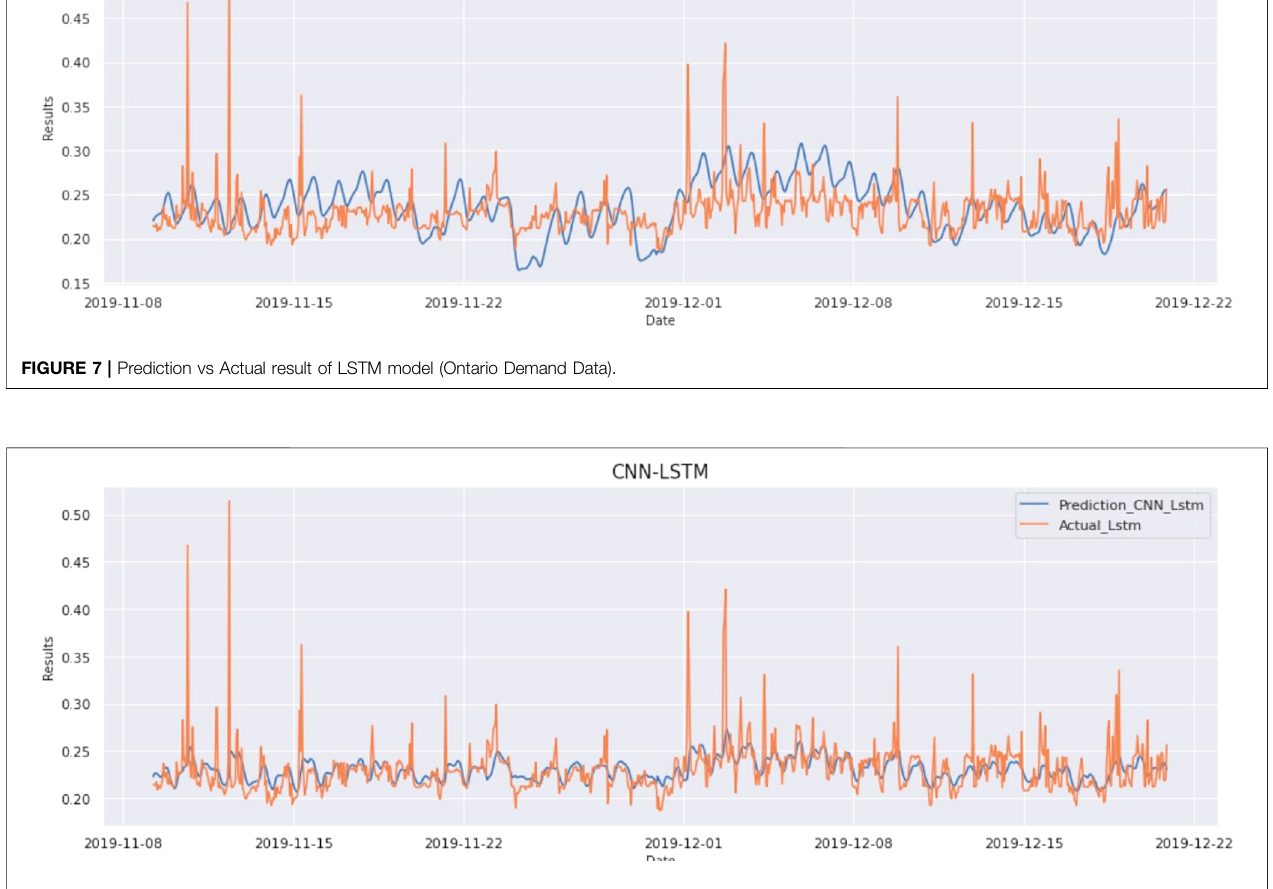
FIGURE 8 | Prediction vs Actual result of CNNLSTM model (Ontario Demand